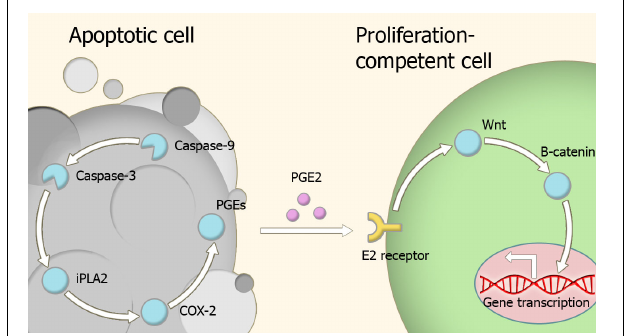
FIGURE 2 | Model of compensatory proliferation. Caspase activity within apoptotic cells leads to the activation of the prostaglandin E2-synthesis pathway. Secreted prostaglandin E2 binds to E2 receptors on proliferation-competent cells, leading to changes in gene expression which trigger proliferation. Abbreviations: iPLA2, Phospholipase A2; COX-2, Cyclooxygenase-2; PGEs, Prostaglandin E synthase; PGE2, Prostaglandin